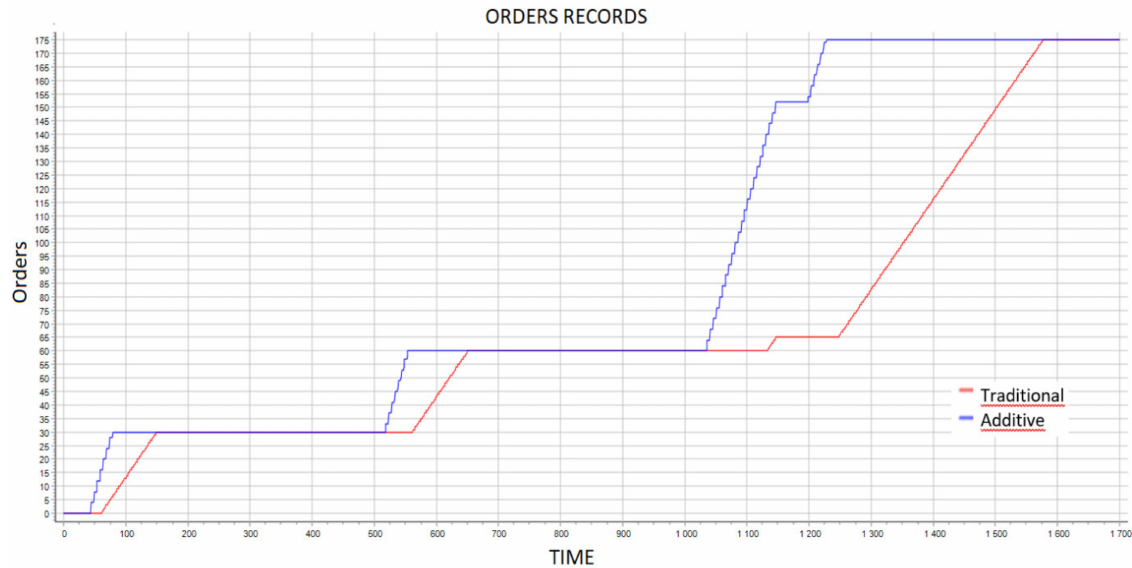
Figure 13. Order record of Demand 2. Source: own elaboration. Evolution